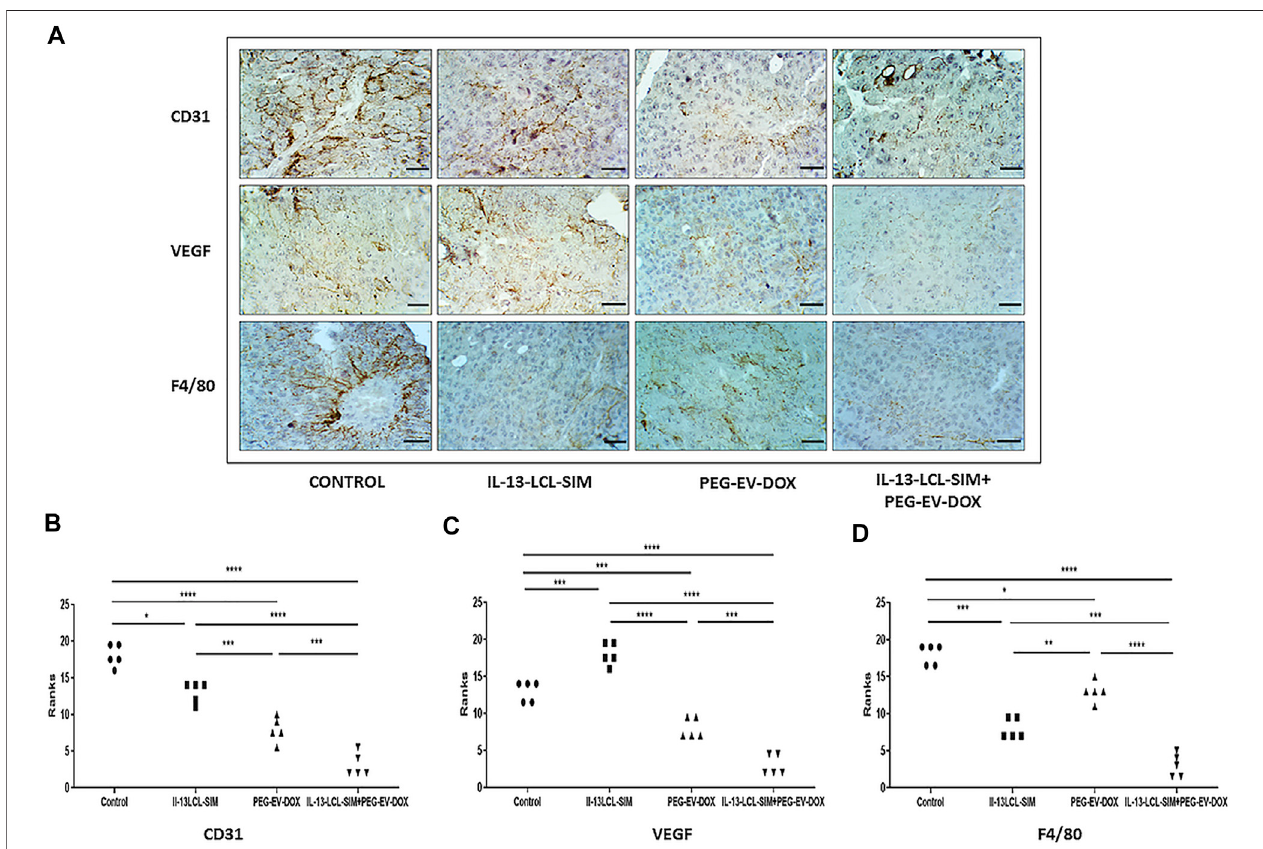
FIGURE 5 | Immunohistochemical analysis of melanoma tissue samples. (A) Immunohistochemical imaging of tumor tissues from B16.F10 melanoma-bearing mice after different treatments. Positively stained cells for CD31, a marker for proliferating endothelial cells, for VEGF, the dominant angiogenesis marker, and for F4/80, the pan intratumor murine macrophage marker appear in brown; size bars = 50 μ m. (B – D) Immunohistochemical scores of angiogenesis markers CD31 (B) and VEGF (C) and of pan macrophage marker F4/80 (D) in B16.F10 murine melanoma sections treated with IL-13-LCL-SIM and PEG-EV-DOX as monotherapies as well as combined sequential therapy. The immunoreaction intensity scores obtained (minimum 5 random fi elds/condition) were analyzed by using a rank-based nonparametric Kruskal – Wallis test with Dunn ’ s test for multiple comparisons. Control, untreated group; IL-13-LCL-SIM, group treated with 5 mg/kg IL-13-LCL-SIM on days 7 and 10 after tumor cell inoculation; PEG-EV-DOX, group treated with 2 mg/kg PEG-EV-DOX on days 8 and 11 after tumor cell inoculation; IL-13-LCL-SIM + PEG-EV-DOX, the groupreceivedthenano-formulationssequentially,IL-13-LCL-SIM5 mg/kgondays7and10,respectively,andPEG-EV-DOX2 mg/kgondays8and11aftertumorcell inoculation; *, p < 0.05; **, p < 0.01; ***, p < 0.001; and ****, p <